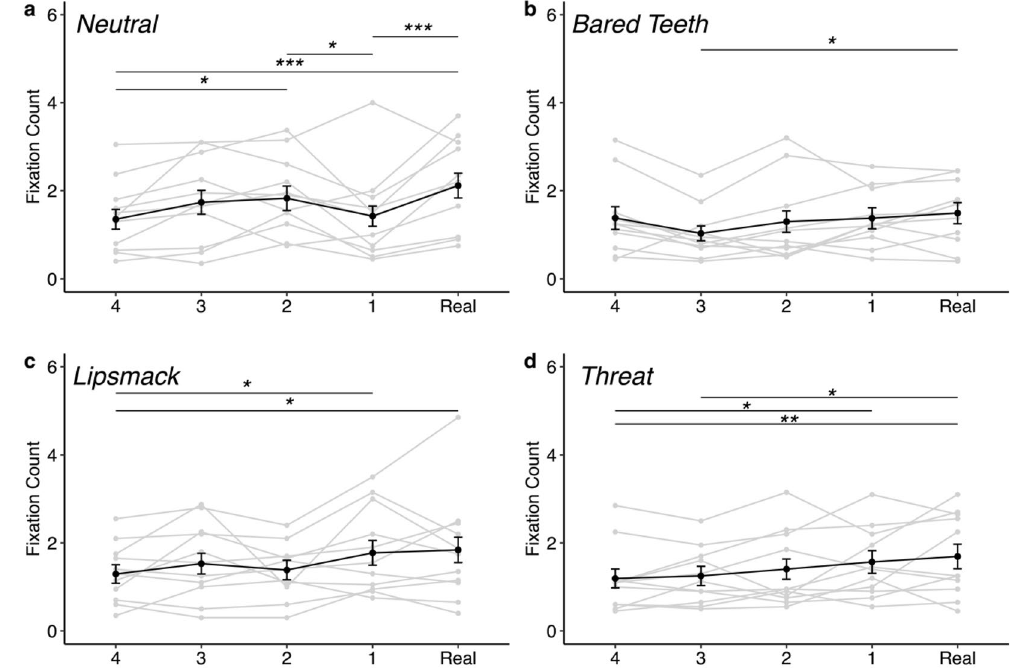
Figure 2. Frequency of fixations on the eyes of the face stimulus as a function of stimulus realness separated by facial behavior of the stimulus. Each subject’s mean behavior is depicted by a gray line and the black line represents the average across all subjects. Each panel represents data from 1040 individual trials. ( a ) Visual attention to the eyes of faces displaying neutral (or no) behavior. Minimal evidence for a UV effect in which subjects fixate less frequently on the Face 1 stimulus than either the Real ( z = − 4.102, p = < 0.001) or Face 2 ( z = 2.75, p = 0.047) stimulus. ( b ) Visual attention to the eyes of faces displaying a bared teeth display revealed no evidence for a UV effect. Subjects looked at the eyes of the real image more frequently compared to the less realistic Face 3 ( z = − 3.15, p = 0.014), but there were no other significant differences between stimulus realness. ( c ) Visual attention to the eyes of faces displaying a lipsmack display reveals no evidence for a UV effect. Subjects looked at the eyes less frequently in the least real image Face 4 compared to either the Real image ( z = − 3.21, p = 0.012) or most real, but still manipulated image, Face 1 ( z = − 2.92, p = 0.029), indicating reduced attention to less realistic eyes. ( d ) Visual attention to the eyes of faces displaying a threat display reveals no evidence for a UV effect. Subjects looked at the eyes fewer times in the least real image Face 4 compared to either the Real image ( z = − 3.35, p = 0.007) or most realistic of the manipulated images, Face 1 ( z = − 2.89, p = 0.032). Subjects also looked at the eyes fewer times in the Face 3 image compared to the Real image ( z = − 2.86, p = 0.034). * p < 0.05, ** p < 0.01, *** p < 0.001. Error bars represent mean ± 95% Confidence